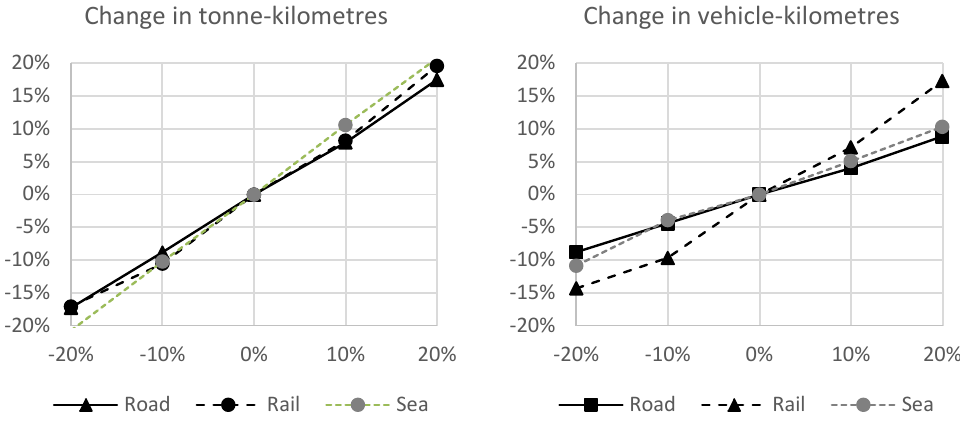
Figure 2. Change in tonne-kilometres and vehicle-kilometres (in percent) per mode inside and outside Sweden as a function of change in total transport volume